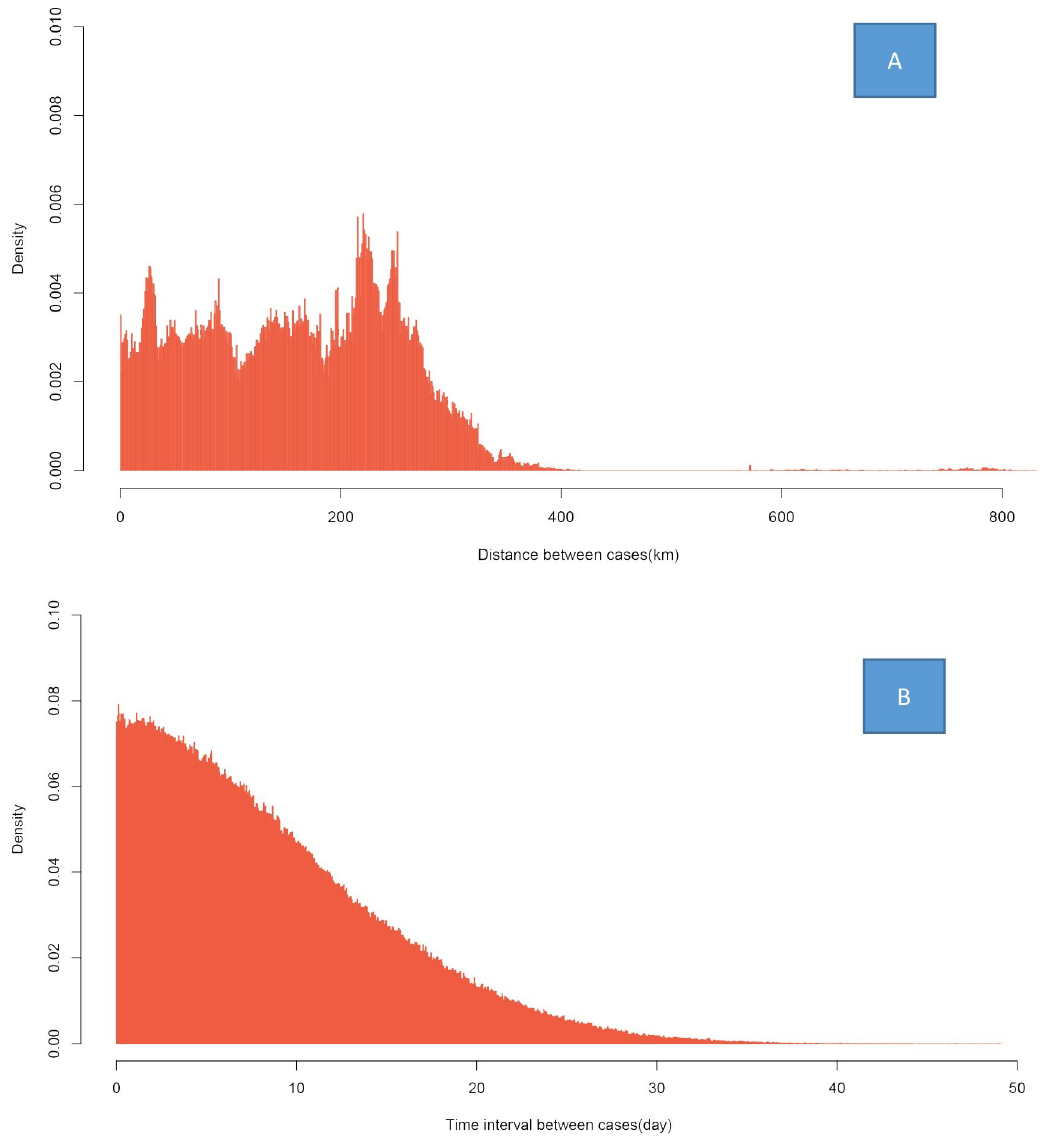
Fig 2. The density distribution of the interval between two COVID-19 cases during the epidemic. (A) The density of the distribution of distance between two cases. (B) The density of the distribution of the onset interval between two cases. In the second step, networks were built, and the relationship between the cases was plotted (Fig 5). In cluster one, the maximum value of node centrality was identified in case A8, with a centrality of 2.9474 (Fig 5A). The node centralities of cases A4, A9, A10 and A3 were 2.9444, 2.9444, 2.9444 and 2.9459, respectively. The node centrality of these cases mentioned above was almost equal, which suggested that these cases were similarly important for transmission in cluster 1. The maximum value of the subcommunities to which these cases belong is 2. In cluster two, the maximum value of node centrality was identified in case B2, with a centrality of 4.3706, followed by B4 (3.5644), B1 (2.6667) and B8 (2.6667). The maximum number of sub- communities to which these cases belong is 4 (Fig 5B). Case B2 is the most important transmis- sion node in cluster 2. In cluster three, the maximum value of node centrality was identified